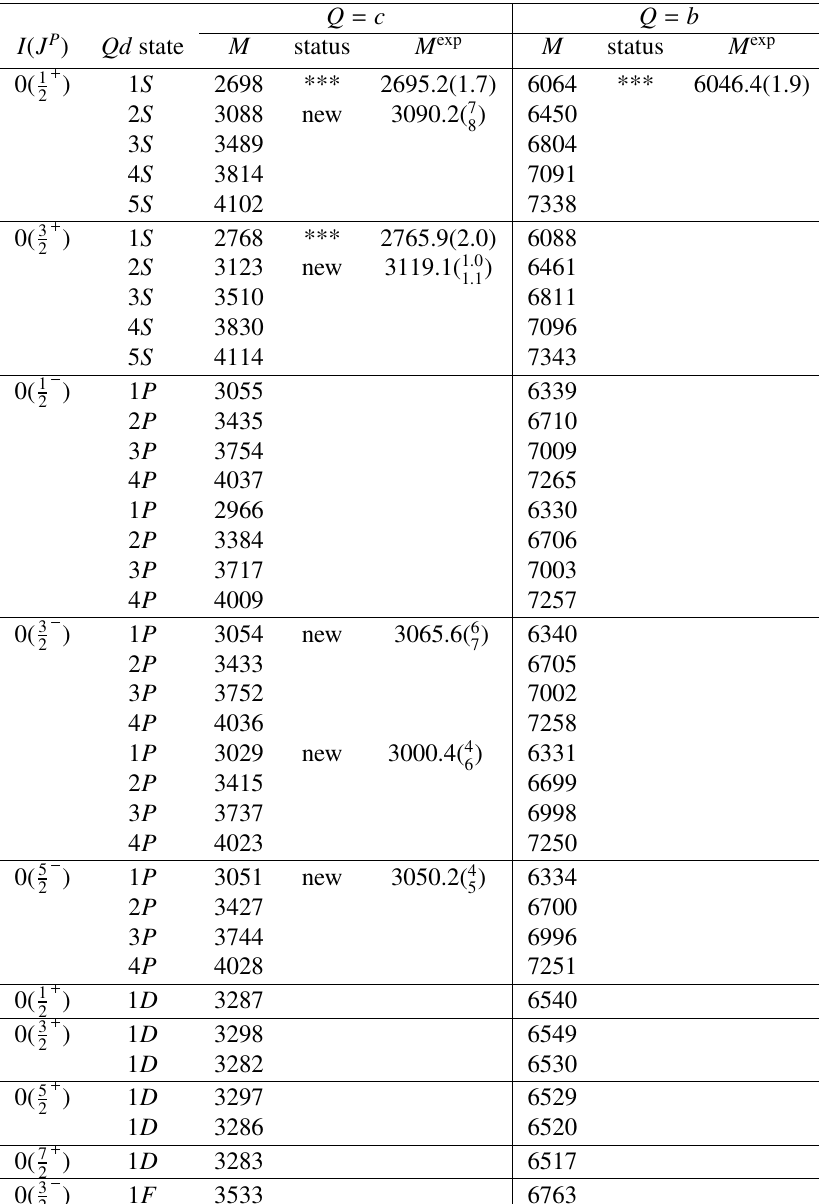
Table 5. Masses of the Ω Q ( Q = c , b ) heavy baryons (in